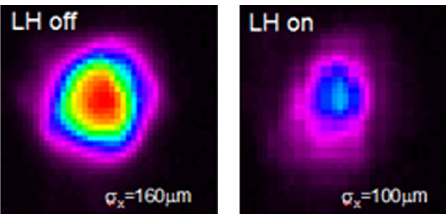
FIG. 11. Transverse electron beam profile imaged on the screen BC01.03 downstream of BC1, with LH off (left) and on (right).